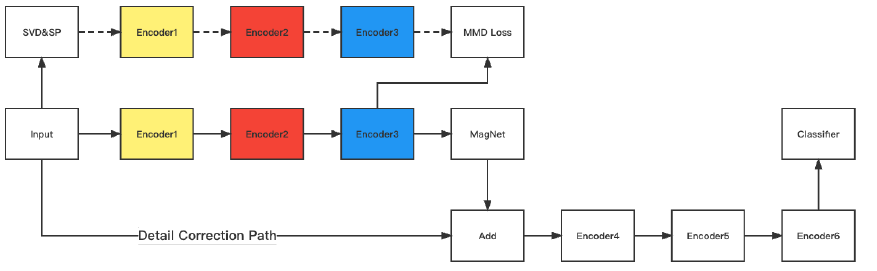
Figure 1. SDViT: the architecture.